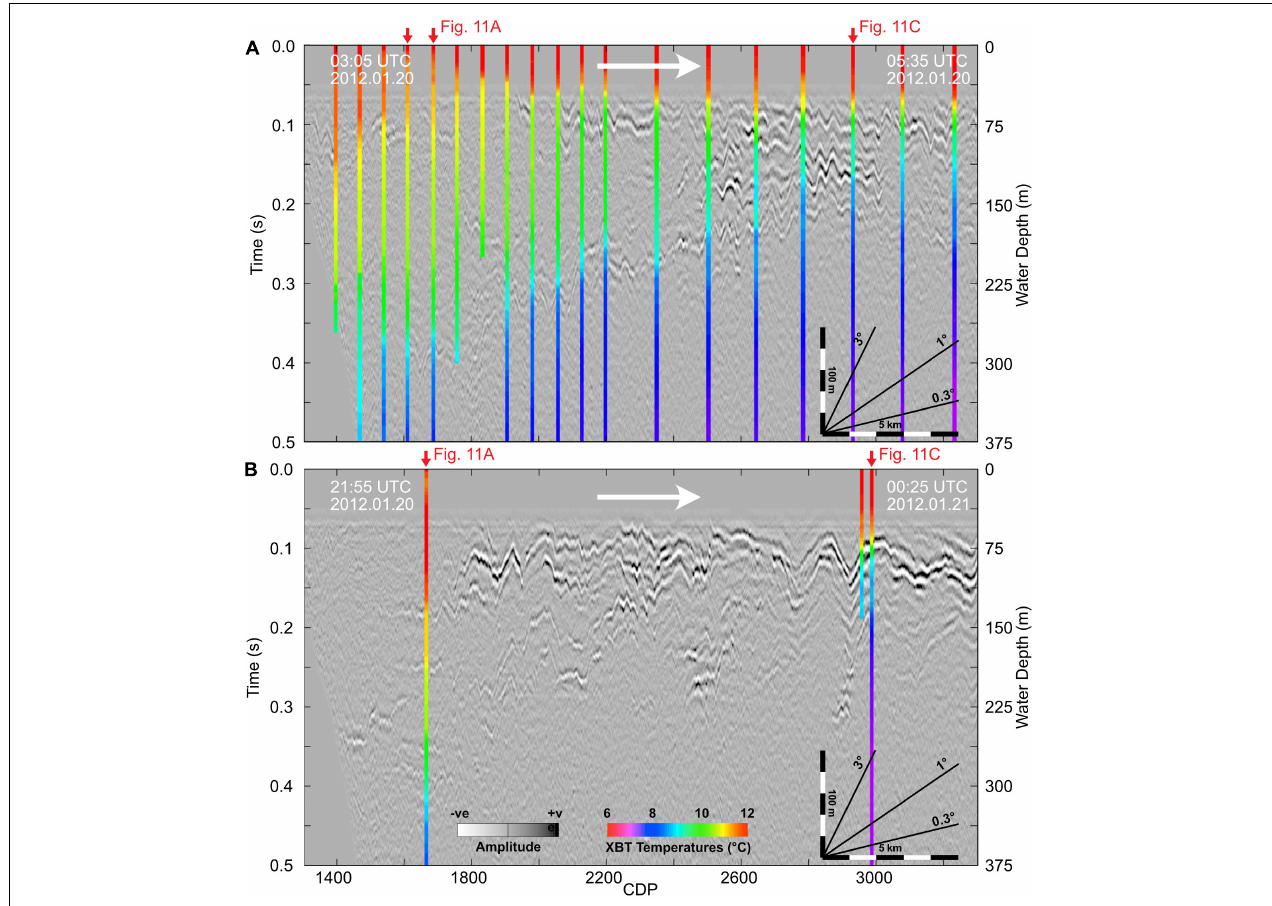
FIGURE 9 | Portions of lines KAH1201-1 (A) and KAH1201-3 (B) acquired in the same location (as indicated in Figure 2 ), with acquisition times and directions indicated by white arrows. Differences in STF reflections (cf. Figure 5D ) can be observed. XBT temperatures are overlain in color. Red arrows indicate the location of XBTs shown in Figure 11